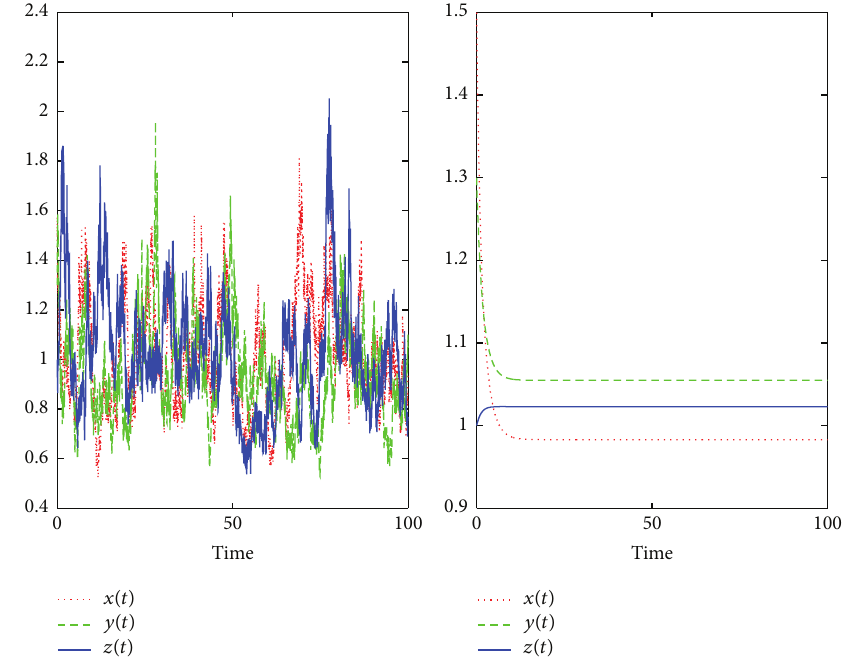
Figure 1: (Stochastic permanence) the trajectories of the solution (𝑥(𝑡),𝑦(𝑡),𝑧(𝑡)) for subsystem (64) and its corresponding deterministic